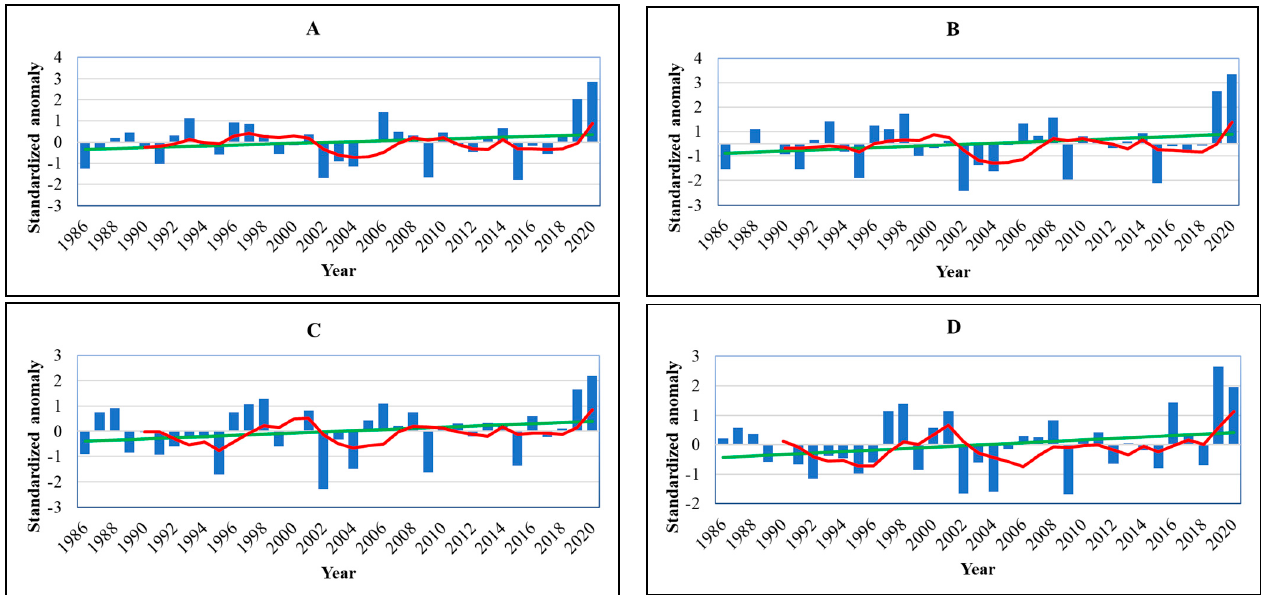
Figure 5. Mean country-wide extreme rainfall indices between 1986 and 2020 periods: ( A ) R10, ( B ) R20, ( C ) R95p, and ( D ) R99p. Note: The straight green line is the linear trend for the variables while the red curved line is the five-year moving average.